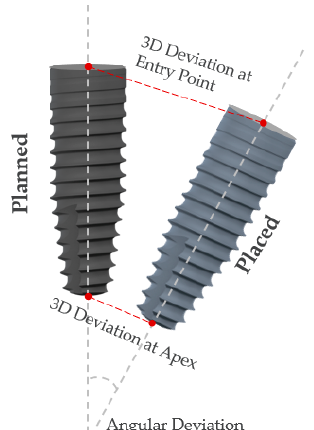
Figure 3. The illustration of 3D measurements represents the implant deviation between the preoperatively planned and the postoperatively placed implant position.